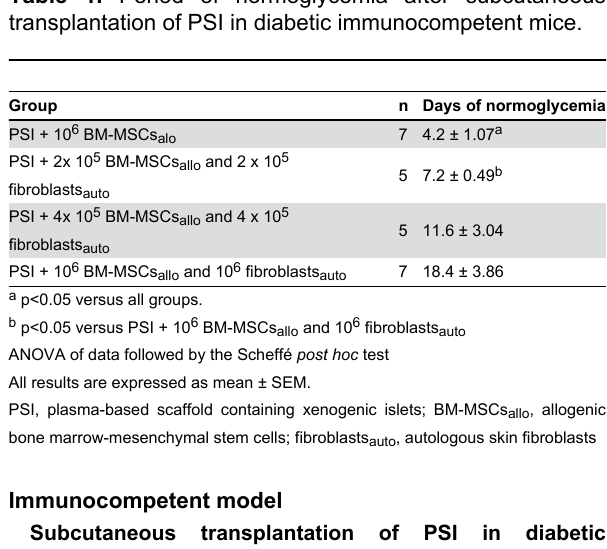
Table 1. Period of normoglycemia after subcutaneous transplantation of PSI in diabetic immunocompetent